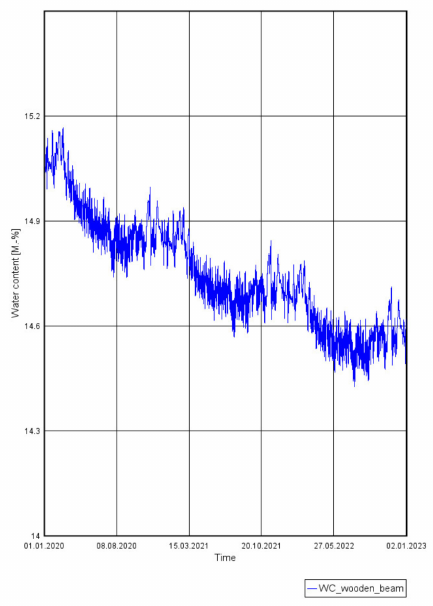
Figure 22. Changes in water content in a wooden beam—partition insulated with mineral wool.